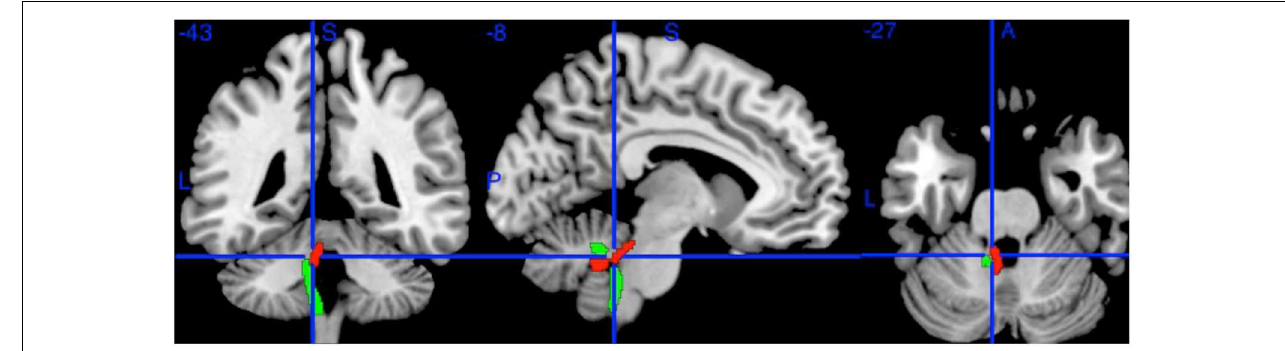
FIGURE 1 | The Left Superior Cerebellar Peduncle (red) and Left Inferior Cerebellar Peduncle (green) from the Johns Hopkins University DTI atlas. The blue crosshairs indicate the center of the 2 mm spherical region of interest (at MNI coordinates − 8, − 43, − 27). Additional ROIs (not shown) were drawn on the Right Superior Cerebellar Peduncle at (6, − 43, − 27) and Left Inferior Cerebellar Peduncle ( − 10, − 42, −